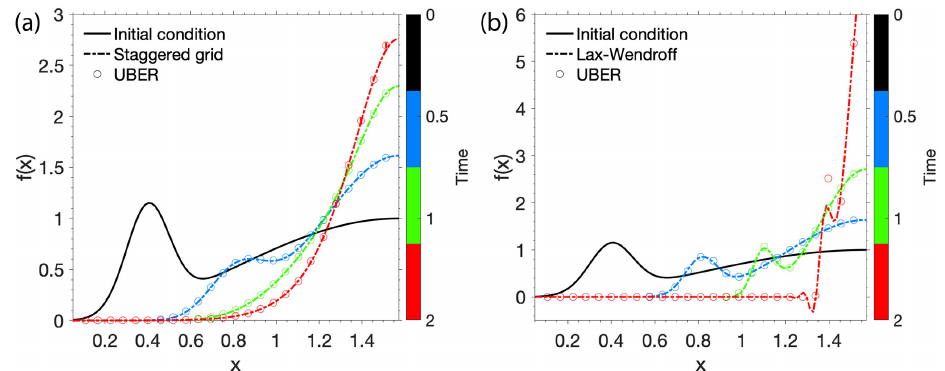
Figure 3. (a) UBER (circles) and staggered-grid finite-difference (dashed line) solutions to the problem in Eqs. (28)–(31). (b) UBER (circles) and Lax–Wendroff (dashed line) solutions to the same problem but with zero diffusion.